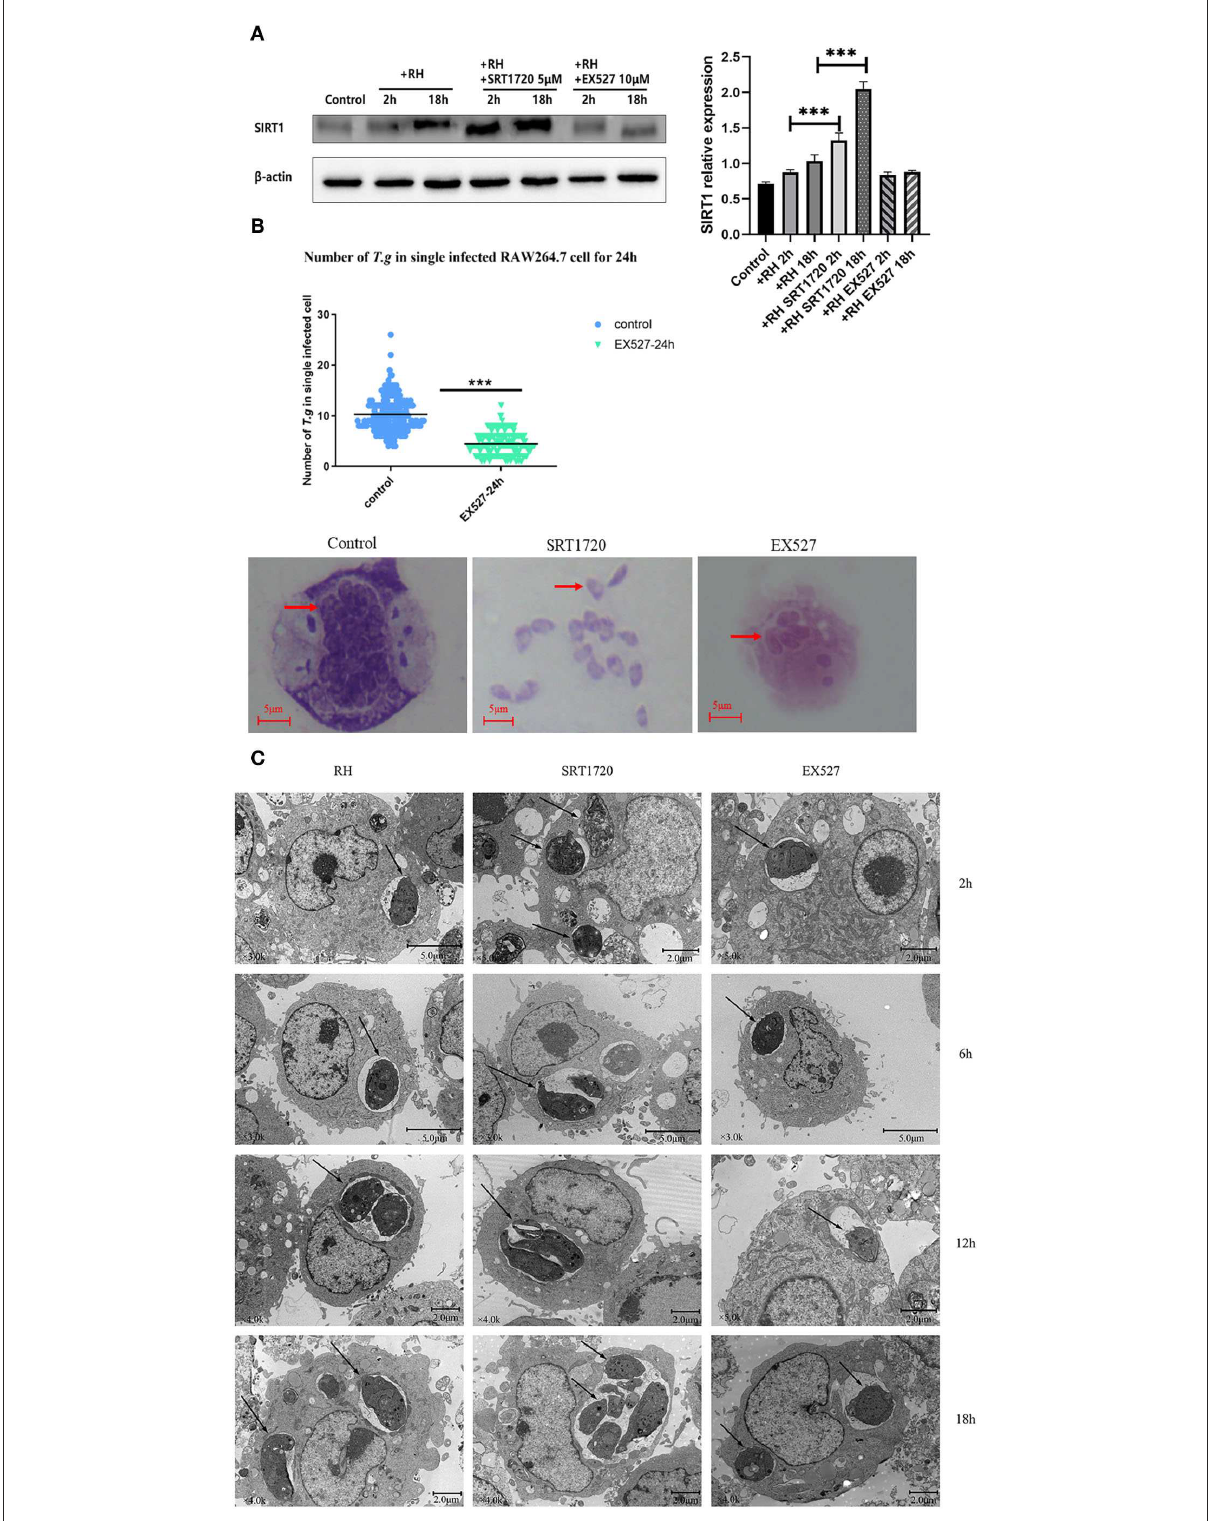
FIGURE2 Intracellular growth of RH tachyzoites with SRT1720 and EX527 in vitro . RH tachyzoites were harvested to infect RAW 264.7 mouse macrophages at an infection ratio of 5:1 (parasite/host cell) for 2h, followed by the removal of excess parasites and stimulation with SRT1720 (5 µ M) and EX527 (10 µ M) for 24h and further examination by staining with Wright’s stain. RAW 264.7 cells stimulated with SRT1720 (5 µ M) and